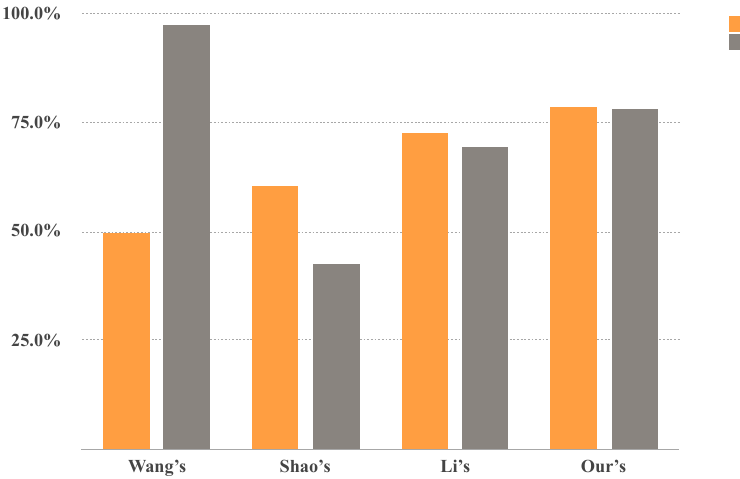
Figure 3. Comparison with other tooth-marked classification methods. Wang and Shao set thresholds based on concavity information, while Li’s and our methods extracted features using CNN. Orange bars represent the accuracy and gray bars represent the recall of these four